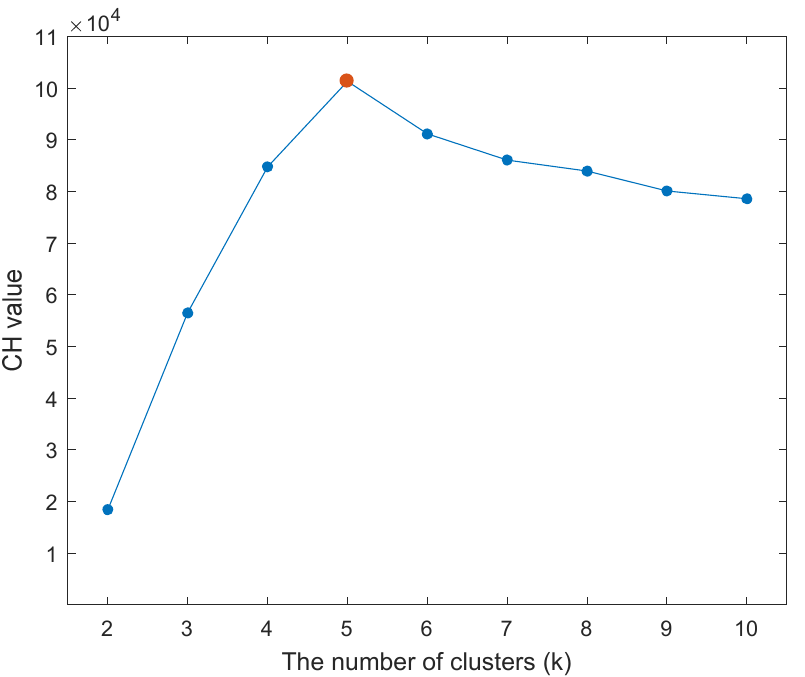
Figure 7. CH values at different number of clusters.